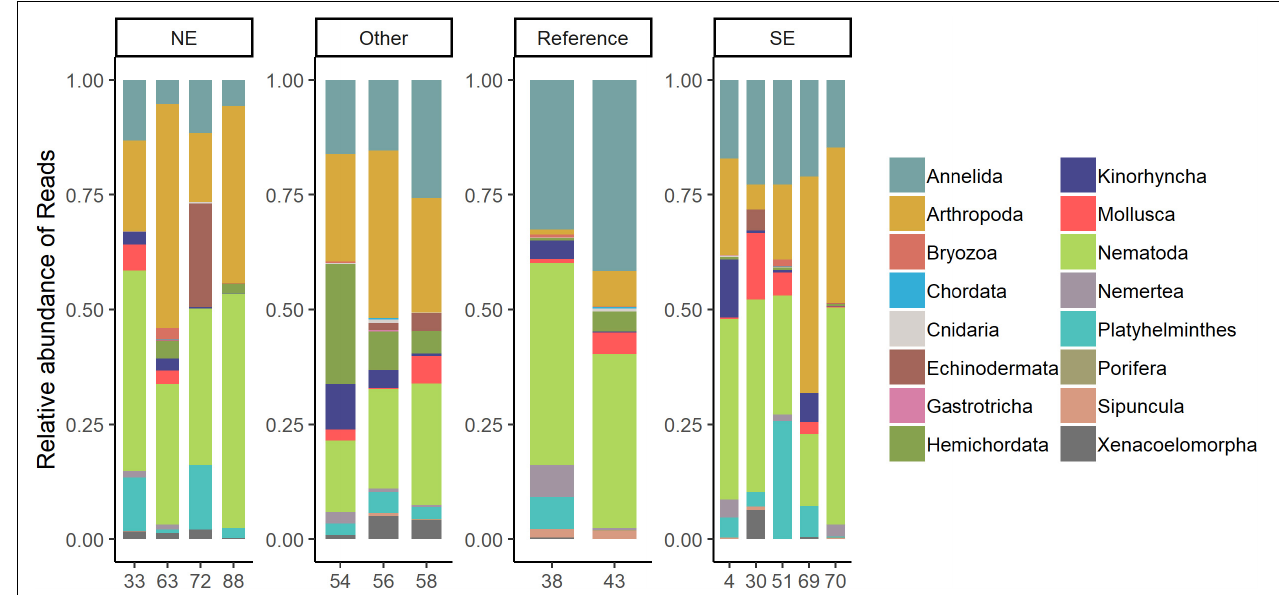
FIGURE 4 | Phyletic composition of the benthic samples per station. For each station the relative abundance of reads per phylum is shown. Stations were clustered into four sites: plume-affected (NE, SE, and Other) and reference based on the clusters found for the trace-elements PCA ( Figure 2